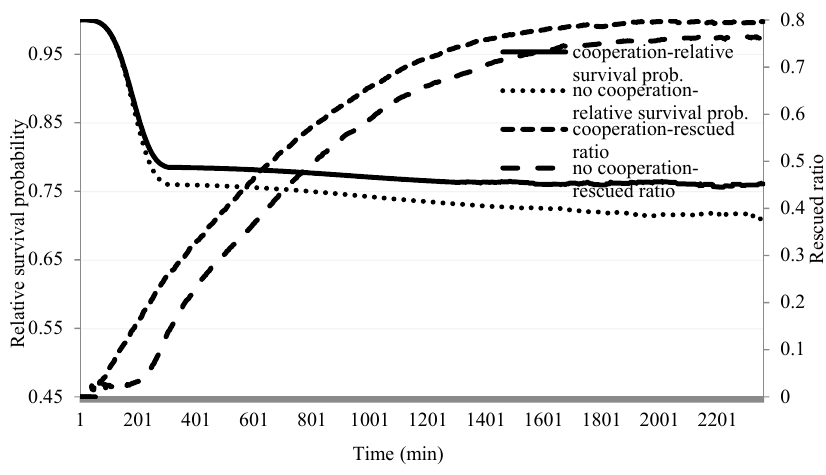
Figure 7. The average output results of 200 runs at every step in scenario “Normal”.